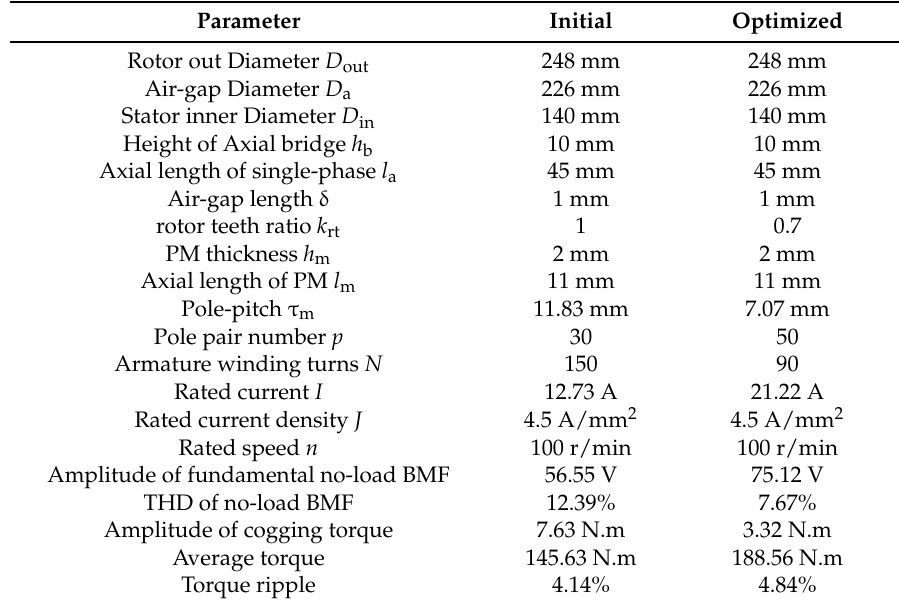
Table 2. Initial and optimized parameters of the CS-TFM.